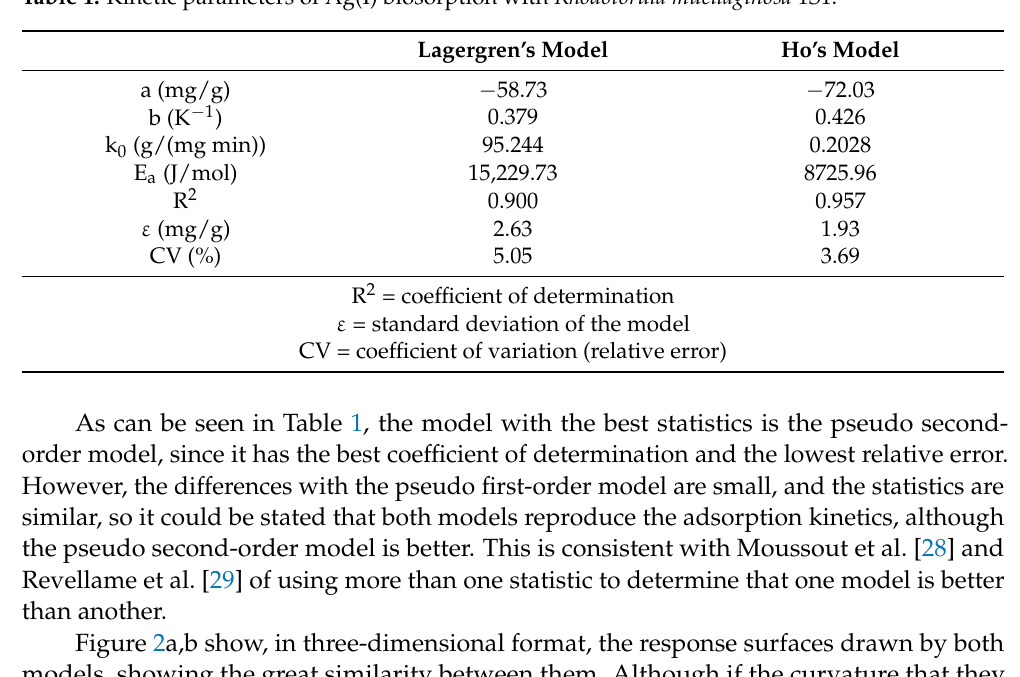
Table 1. Kinetic parameters of Ag(I) biosorption with Rhodotorula mucilaginosa